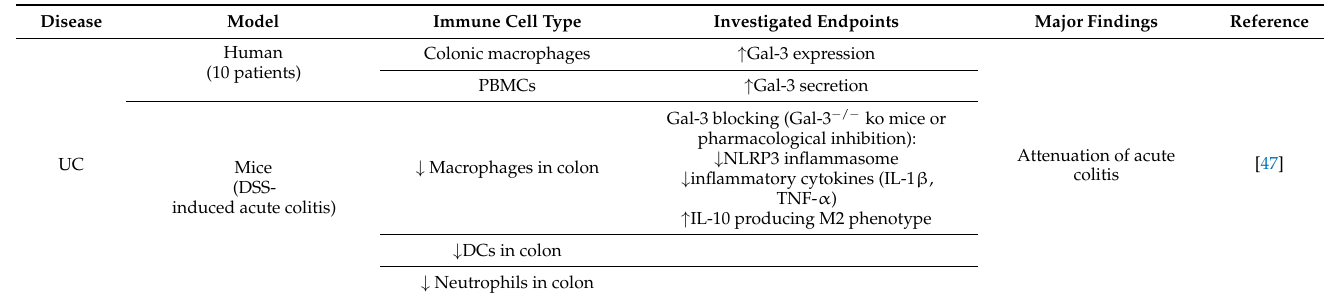
Table 1. Studies describing the effects of galectin-3 on the immune system in the context of ulcerative colitis and colorectal